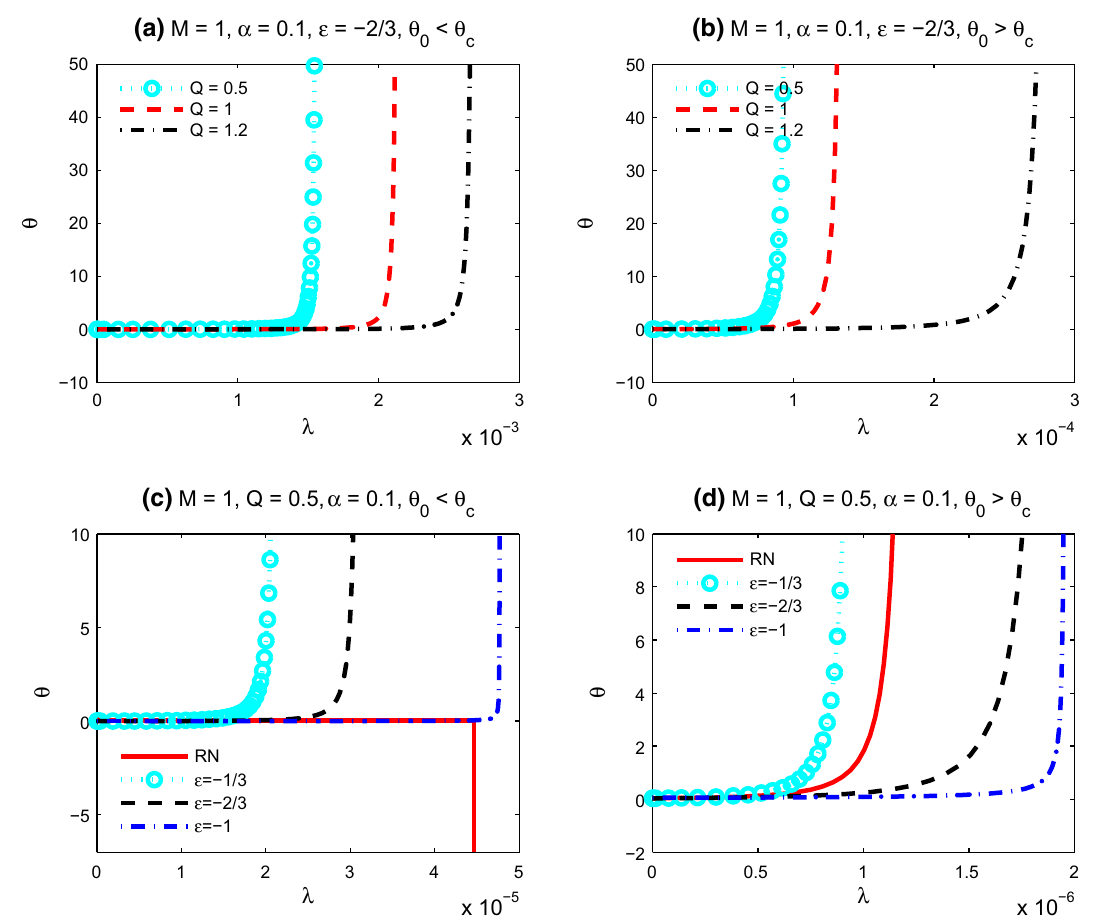
Fig. 5 The evolution of expansion scalar ( θ ) with the BH charge ( Q ) and the EOS parameter ( ε ) with no initial shear and